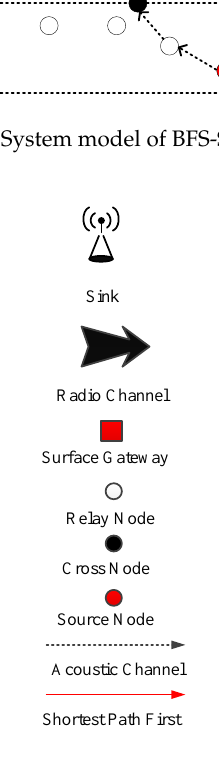
Figure 5. Legends of above Discussed